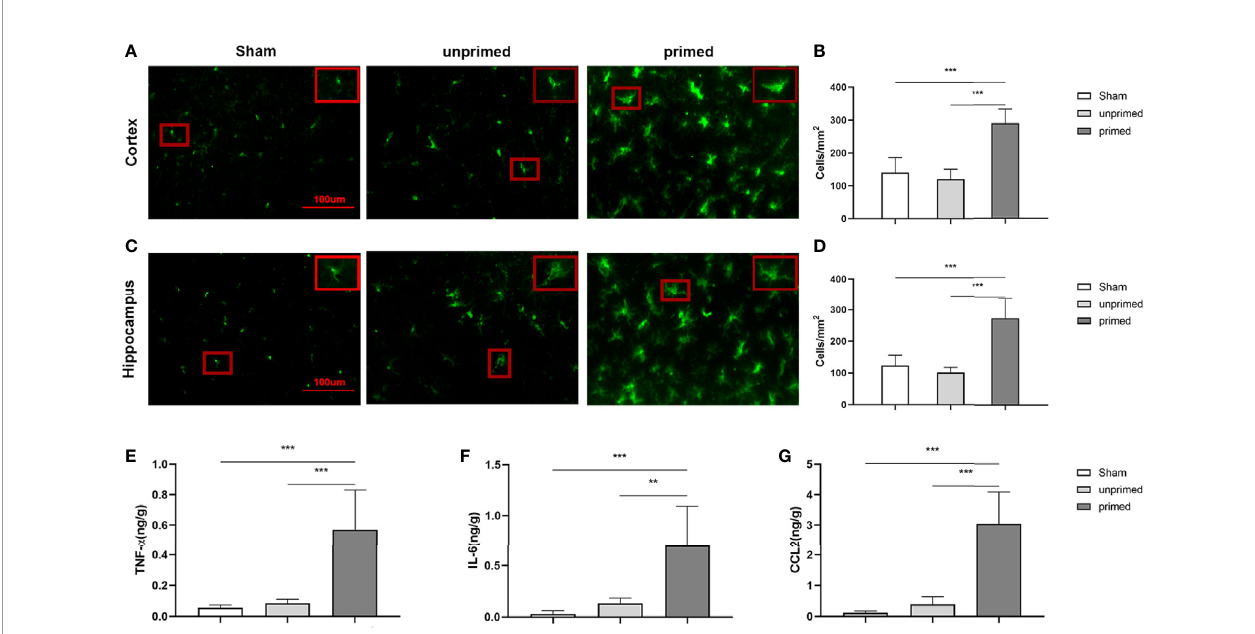
FIGURE 11 | BAFF induced microglial training in vivo . Immuno fl uorescence staining of Iba1 in the cortex (A) and hippocampus (C) . Comparisons of the numbers of Iba1-positive microglia in the cortex (B) and hippocampus (D) (n = 6). A representative Iba-1+ cell from the cortex is shown magni fi ed in the red box in the image ’ s right upper corner. The expression of TNF- a (E) , IL-6 (F) , CCL2 (G) were measured in the supernatants by ELISA on day 7(n = 6). Data are mean ± SEM; Kruskal- Wallis test with Turkey post hoc test; **p < 0.01, and ***p <